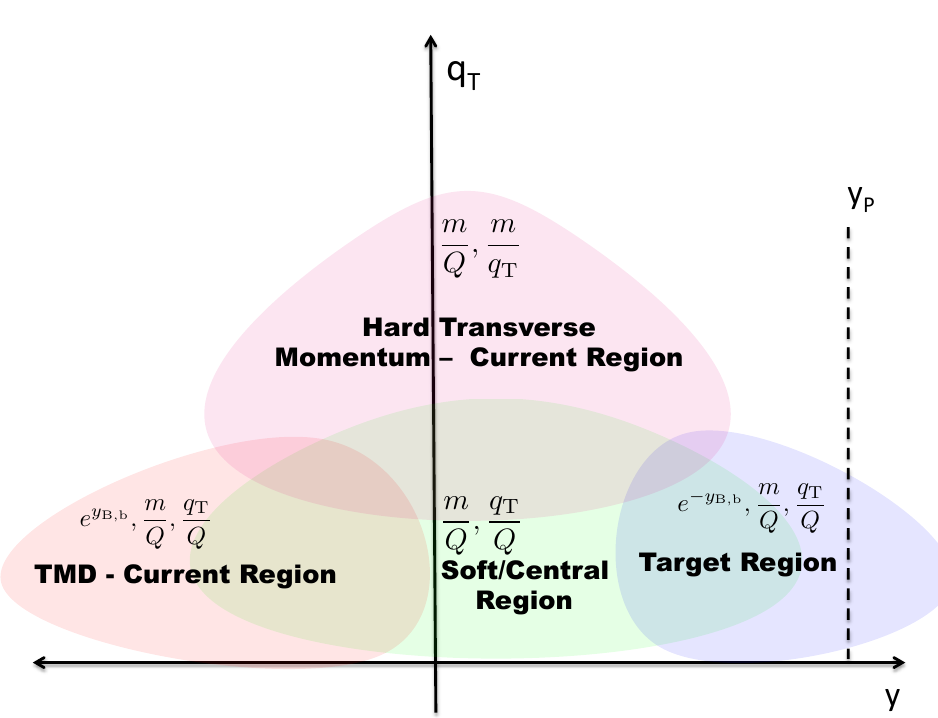
Figure 8 . Sketch of kinematical regions of SIDIS in terms of the produced hadron’s Breit frame rapidity and transverse momentum. In each region, the type of suppression factors that give factorization are shown. (The exact size and shape of each region may be very di(cid:11)erent from what is shown and depends on quantities like Q and the hadron masses.) In the Breit frame, according to eq. (E.7), partons in the handbag con(cid:12)guration are centered on y The shaded regions in the sketch are shifted somewhat toward the target rapidity y P; b (the vertical dashed line) to account for the behavior of the rapidities, eq. (E.1), when z N and x N are